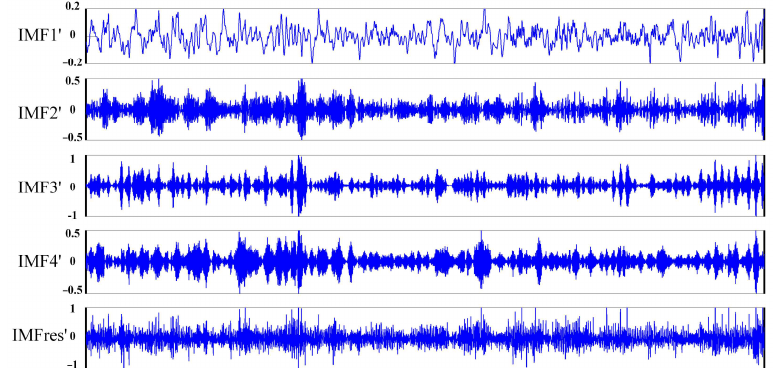
Figure 5. Decomposition results of IMF-worst.